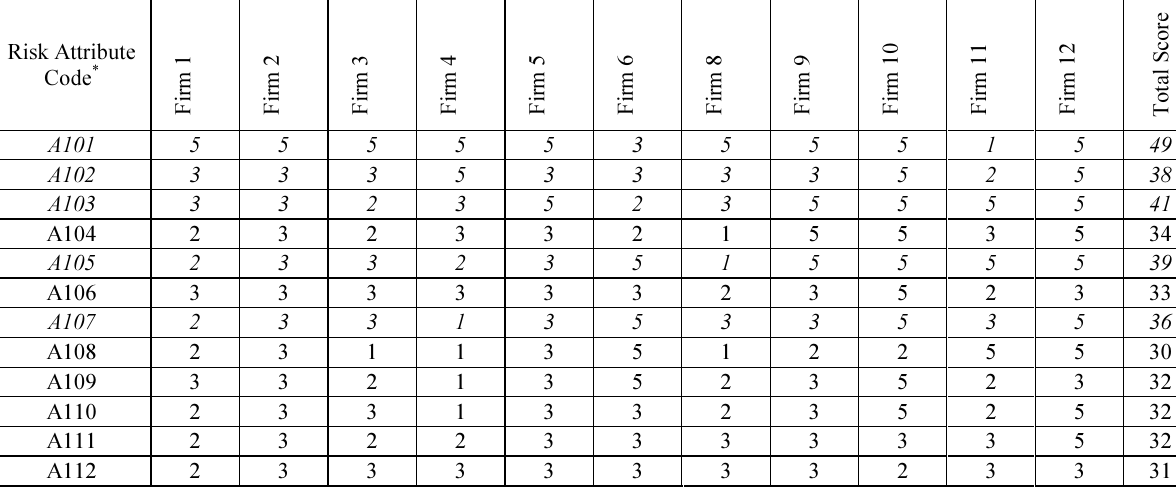
Risk Factor (A1) – Quality of Services